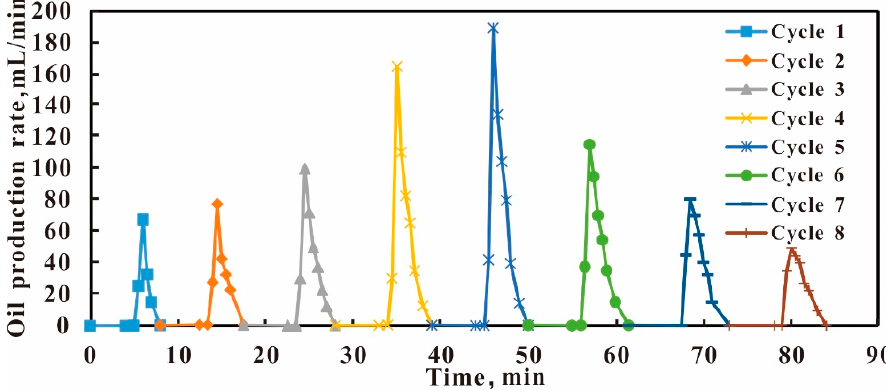
Figure 8. Oil production rate in each cycle.